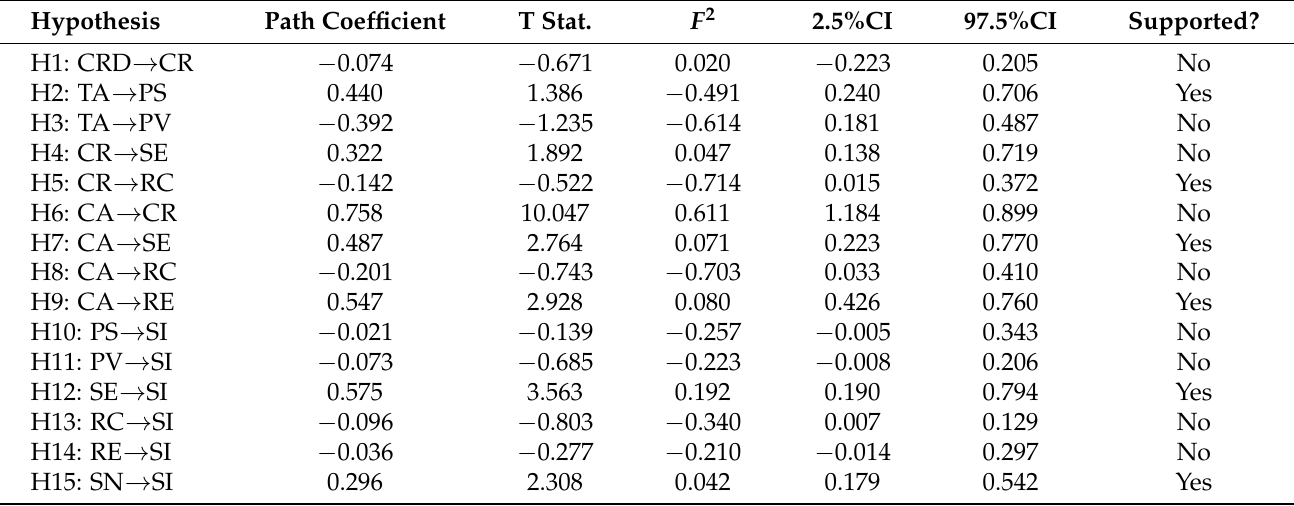
Table 4. Overview of PLS-SEM results of structural model